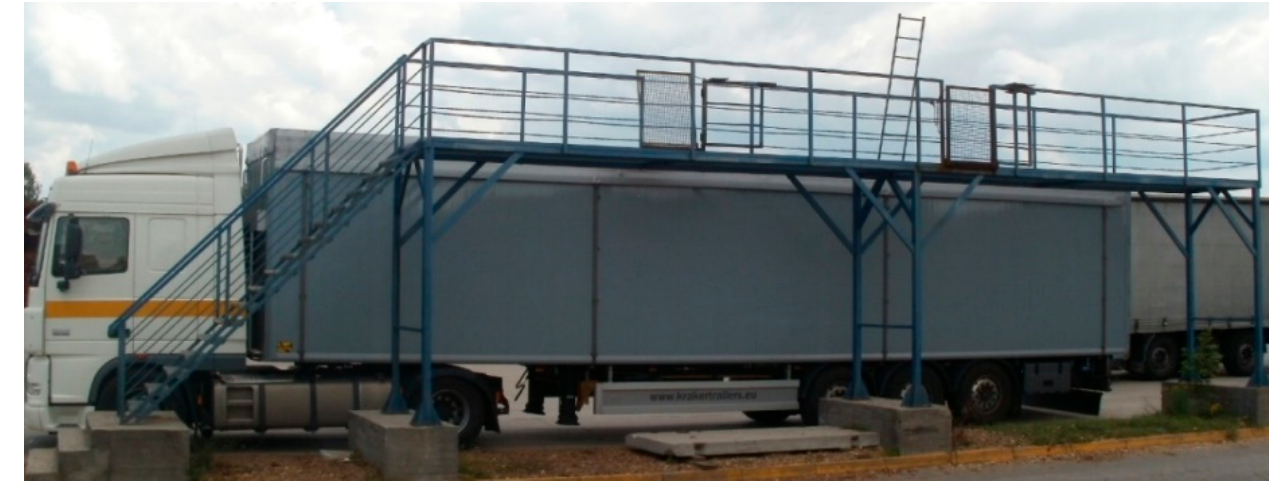
Figure 3. A station for measuring the bulk volume of loads.